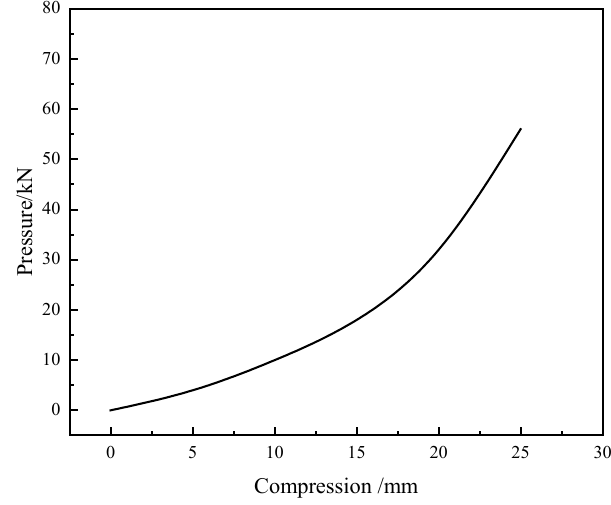
Figure 5. Mechanics performance curve of rubber material used in the study.